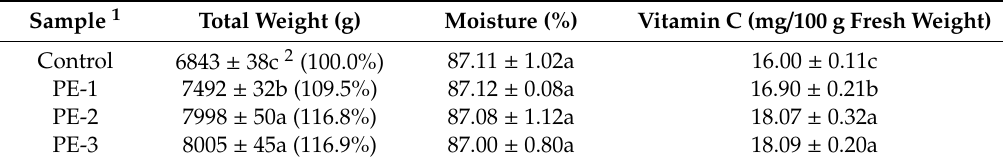
Table 1. E ff ect of Pu-erh tea extracts on yield, moisture, and vitamin C content of soybean sprouts grown for 6 days.